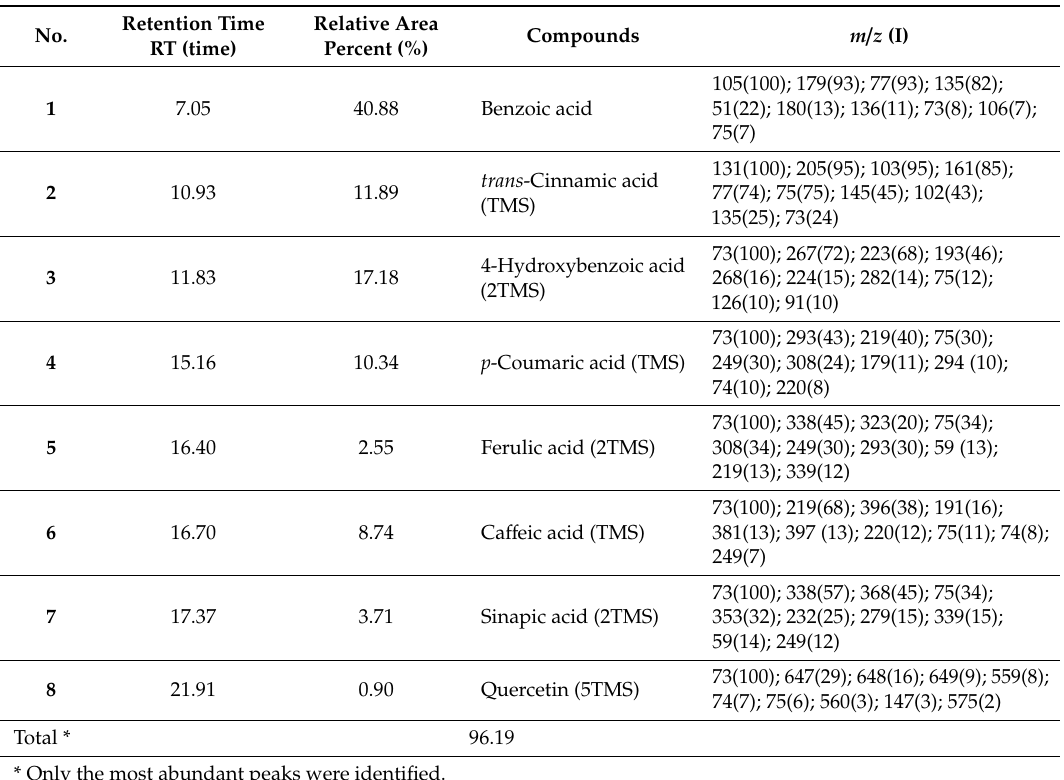
Table 1. Chemical composition of thyme waste extract. Total polyphenols content and DPPH activity of thyme waste